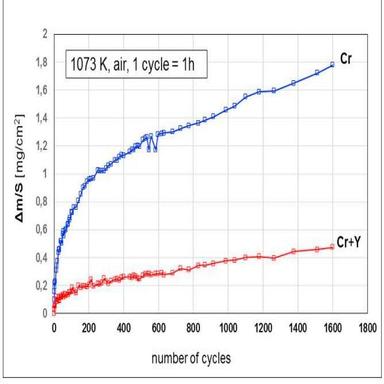
Mass change during cyclic oxidation (1073 K, air, 1600 × 1 h) for unmodified chromium and chromium implanted with yttrium ions (2 × 1016 Y/ cm2 ).